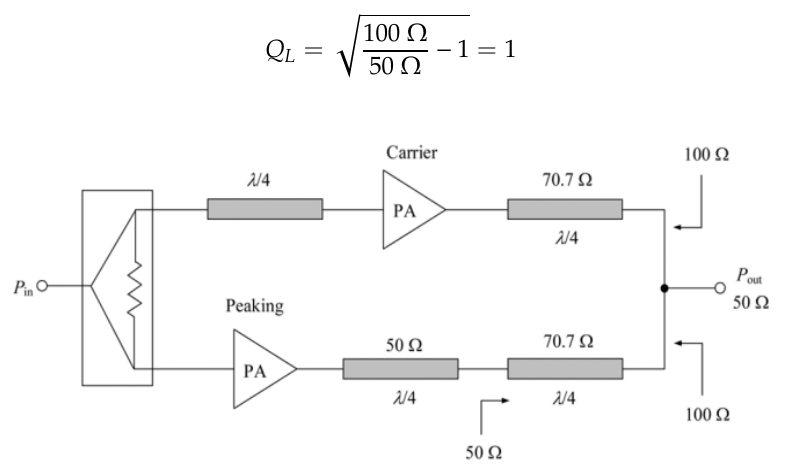
Figure 9. Modified Doherty amplifier proposed by [31].